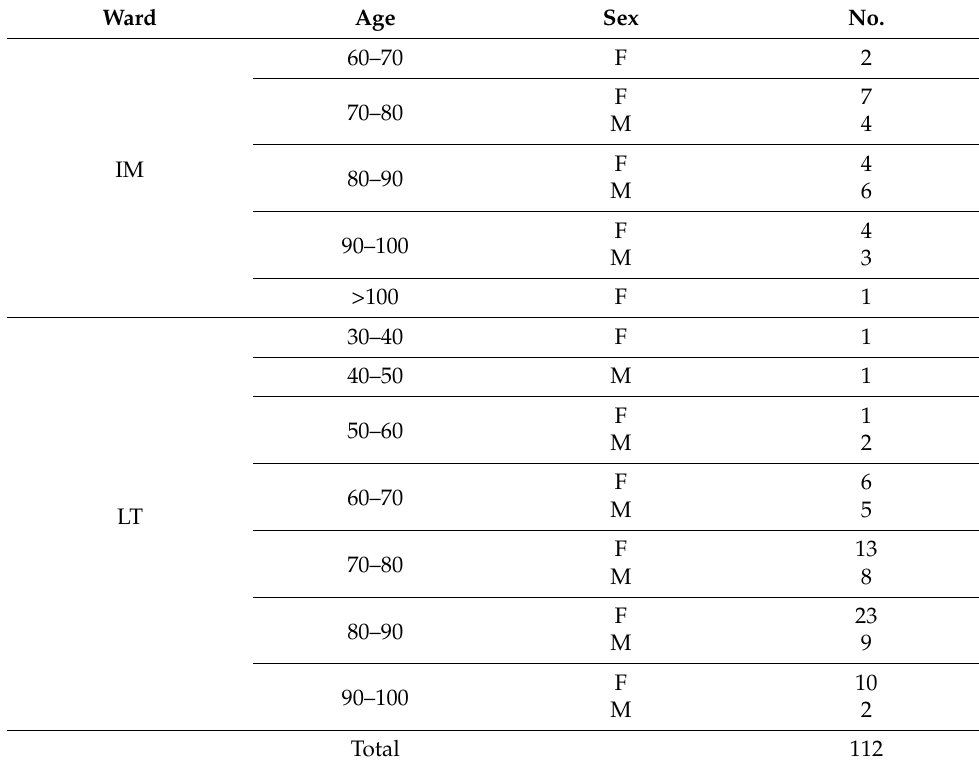
Table 1. Demographic information of the 112 patients whose samples were analysed. Ward Age Sex No.